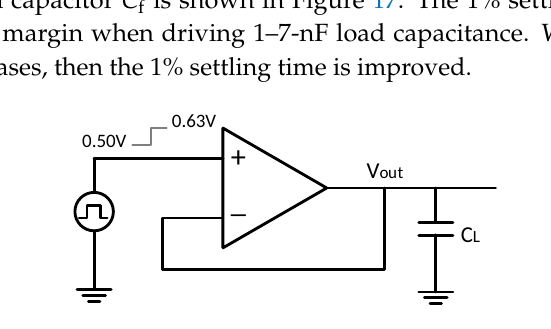
Figure 15. Test-bench circuit for step response simulation.